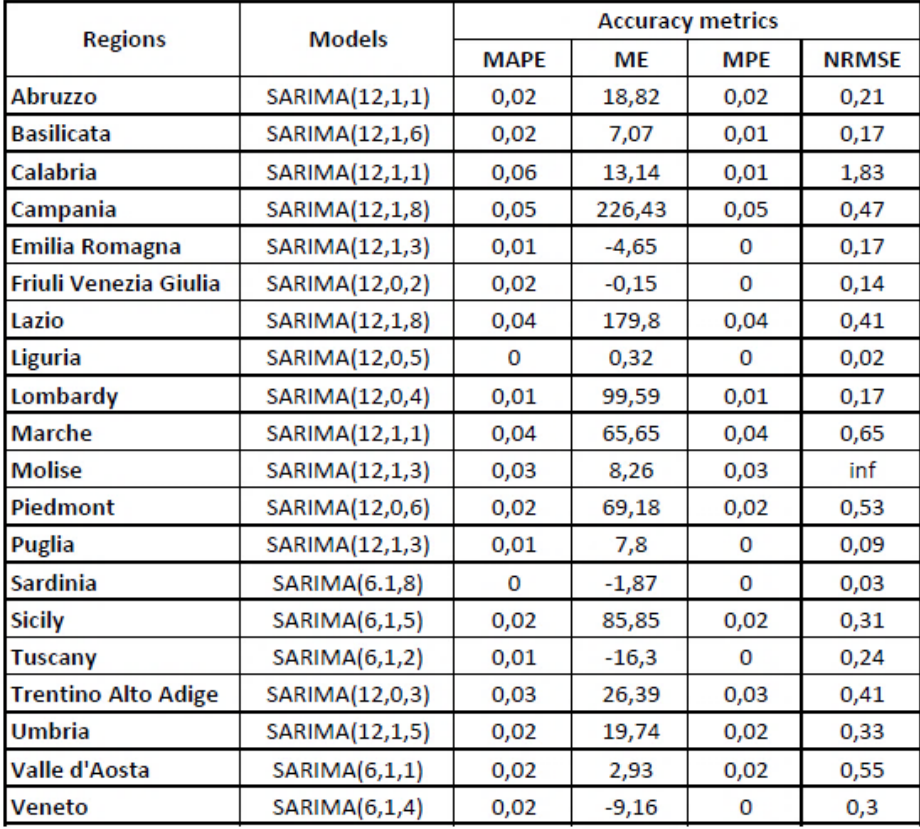
Table 5. Regional models and accuracy metrics